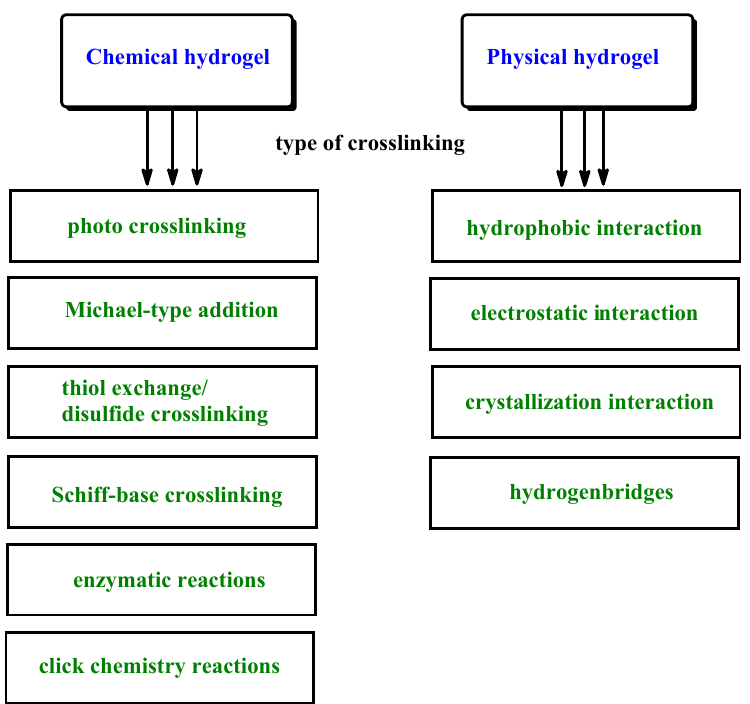
Figure 1. Chemical and physical hydrogels – type of cross-linking techniques.